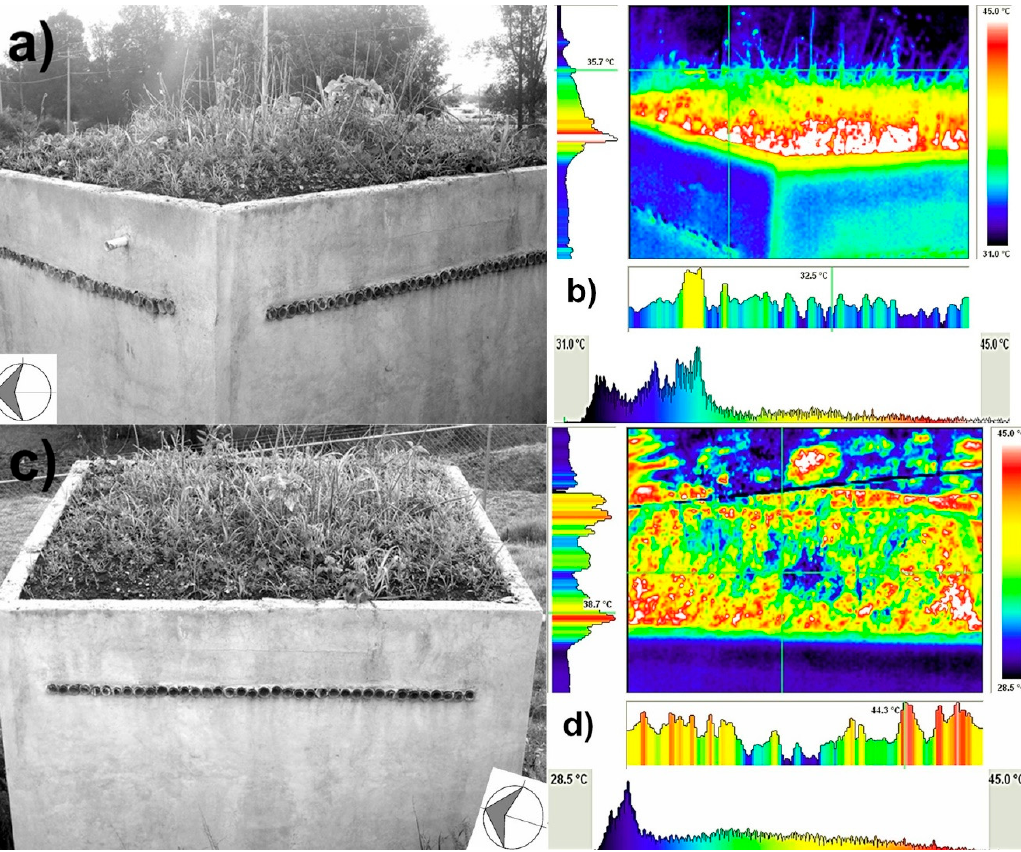
Figure 5. Photographs and thermograms of the PET prototype in different top views: ( a ) photography and ( b ) thermal image, northwestern and southwestern side view; ( c ) photography and ( d ) thermal image, southwestern (rear) view.